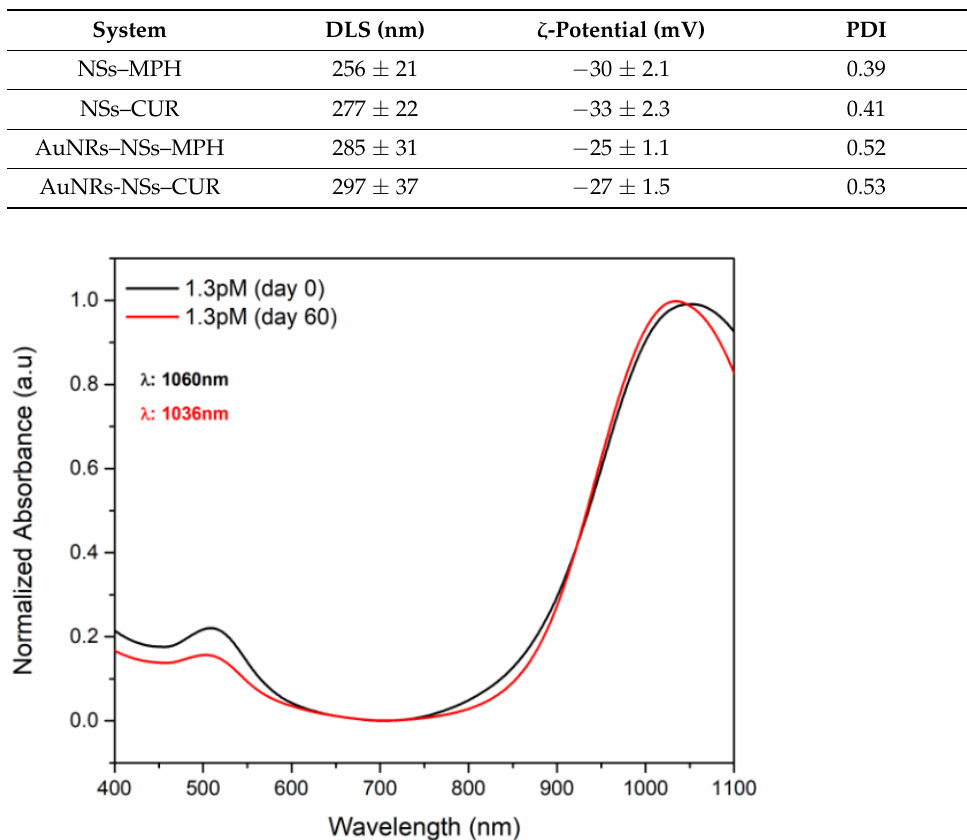
Figure A1. UV-Vis NIR-II spectra of the IC-AuNRs following storage at 4 °C for 2 months.